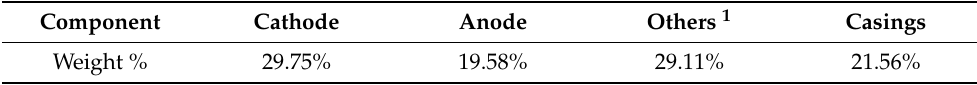
Table 3. LIB component weight fractions.